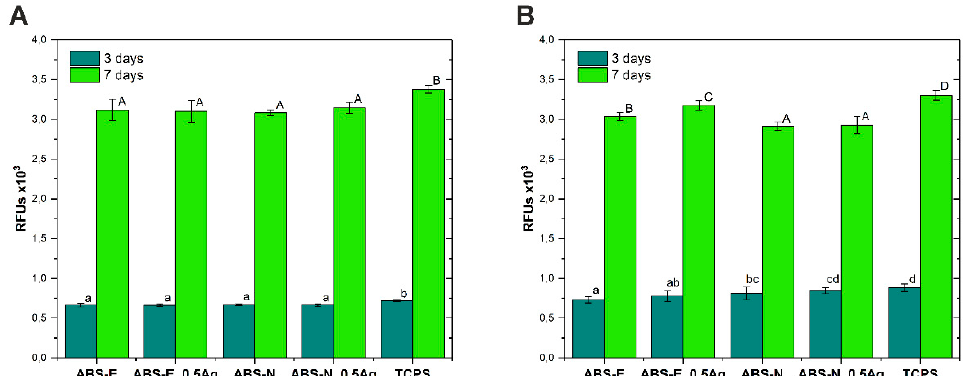
Figure 5. Metabolic activity of Saos-2 ( A ) and Hs680.Tr ( B ) cells after 3 and 7 days of culture in direct contact with the materials tested in the Presto-Blue test. The results are presented as mean values ± standard deviation. Statistically significant differences ( p < 0.05) between the tested materials are marked a-d for 3-day culture and A-D for 7-day culture.